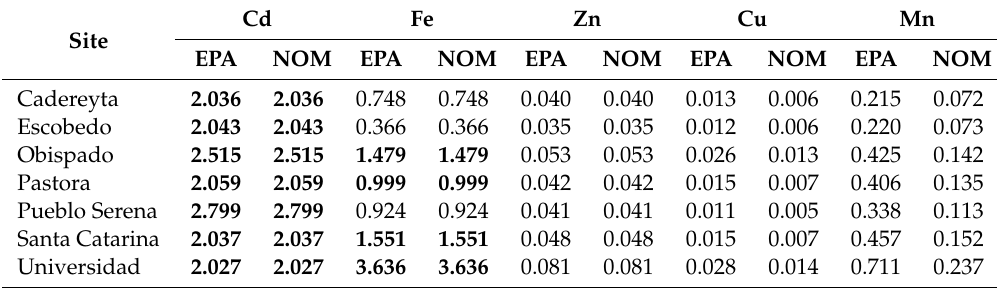
Table 4. Toxicity potential (TP) values of studied metals evaluated under two di ff erent upper limits (EPA—Environmental Protection Agency and NOM—Mexican regulations) by monitoring